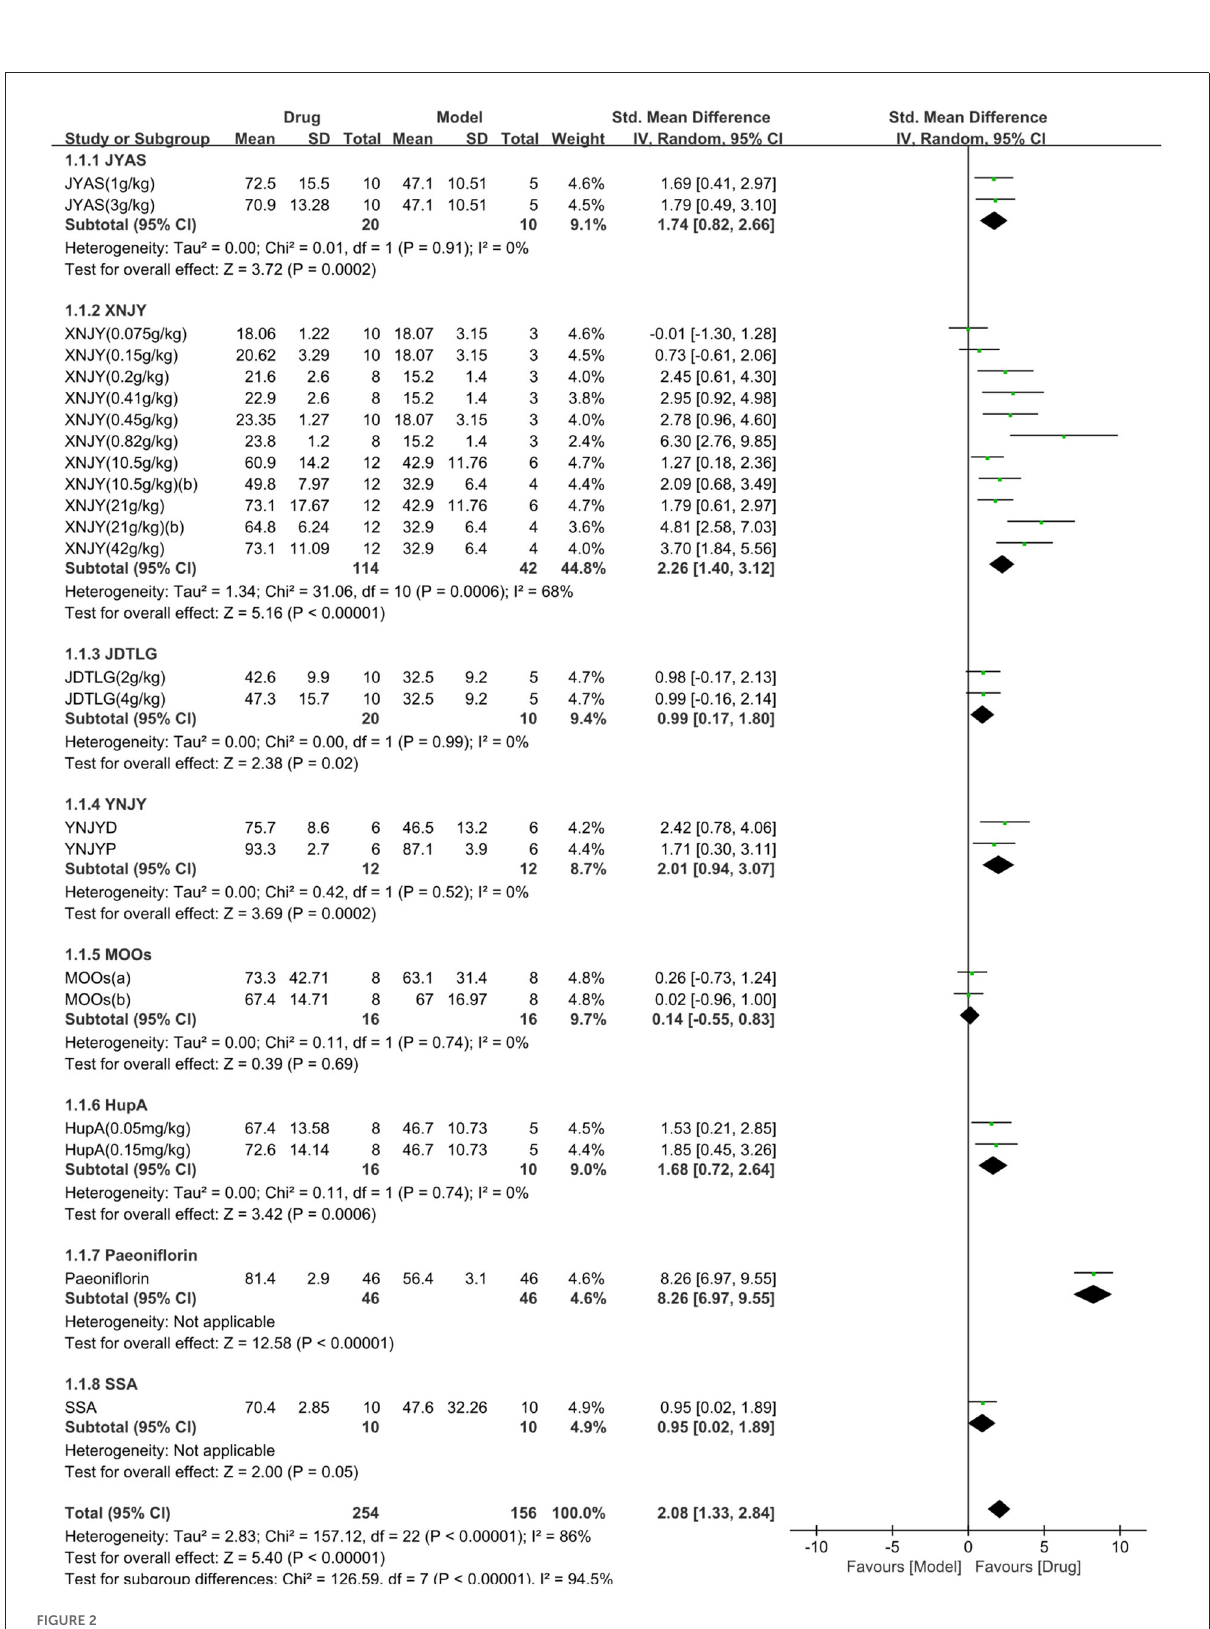
FIGURE2 Efficacy of Chinese herbal medicine (CHM) on sucrose preference test. Forest plots of the effect size calculated using standardized mean differences (SMDs). The horizontal error bars represent the 95% confidence interval of individual